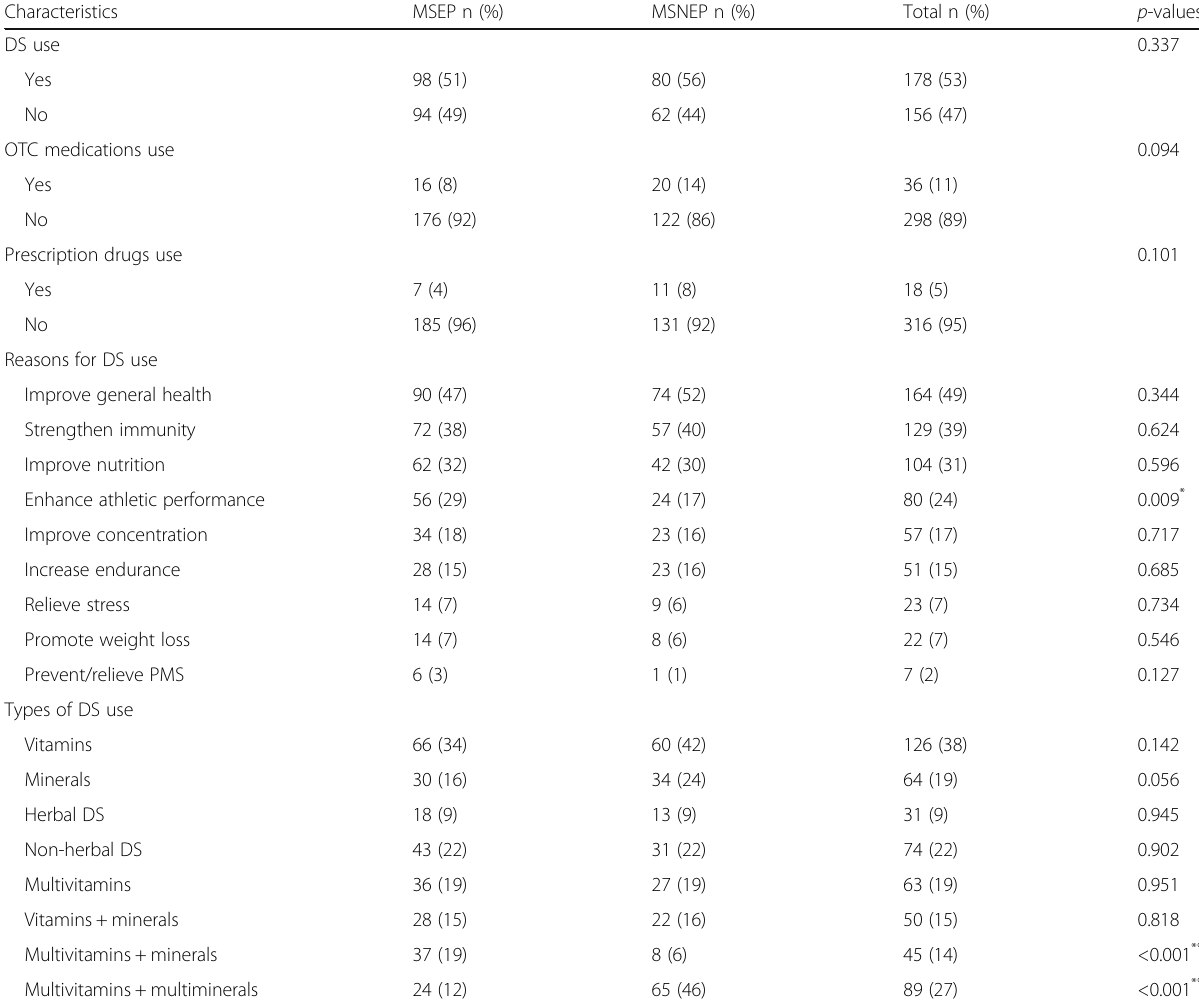
Table 2 Consumption and reasons for use of DS by medical students